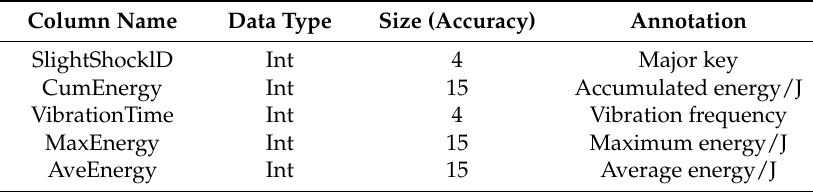
Table 8. Slight shock dimension table